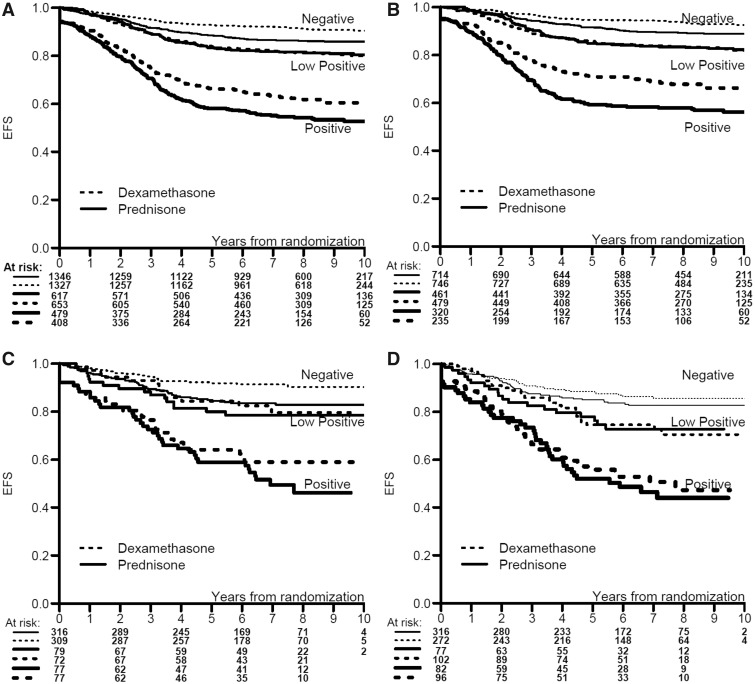

A–D) Event-free survival (EFS) curves by treatment within minimal residual disease (MRD) categories: A) overall, B) in AIEOP-BFM, C) in COG-HD, and D) in COG-Capizzi group.